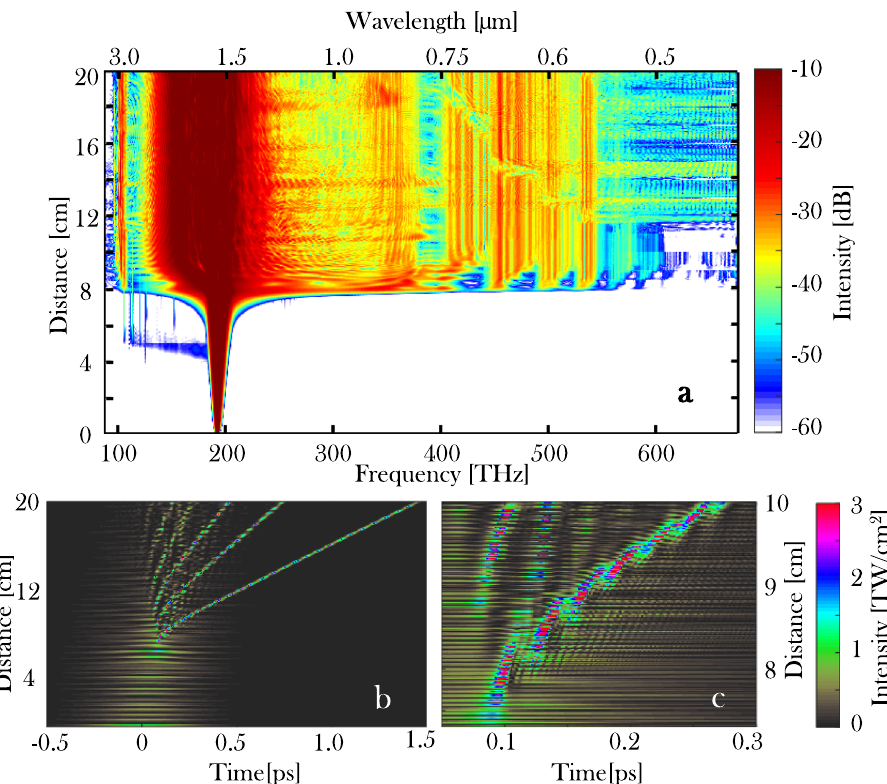
Fig. 1 Temporal and spectral evolution of a multimode optical pulse in a graded-index multimode fi ber. a Spectral evolution of a 400-fs pulse (150 nJ ) at 1550 nm after propagating in a 20 cm long graded-index multimode fi ber having a core diameter of 62.5 µ m, NA = 0.275 as obtained from a gUPPE simulation. b Temporal evolution of this same pulse, under the same conditions. c A closer look at multiple fi ssions and of the red-shifting of the fi rst emerging soliton right after the primary soliton fi ssion event. The horizontal axes of b and c are expressed in a moving coordinate frame T = t – z/v 42 .